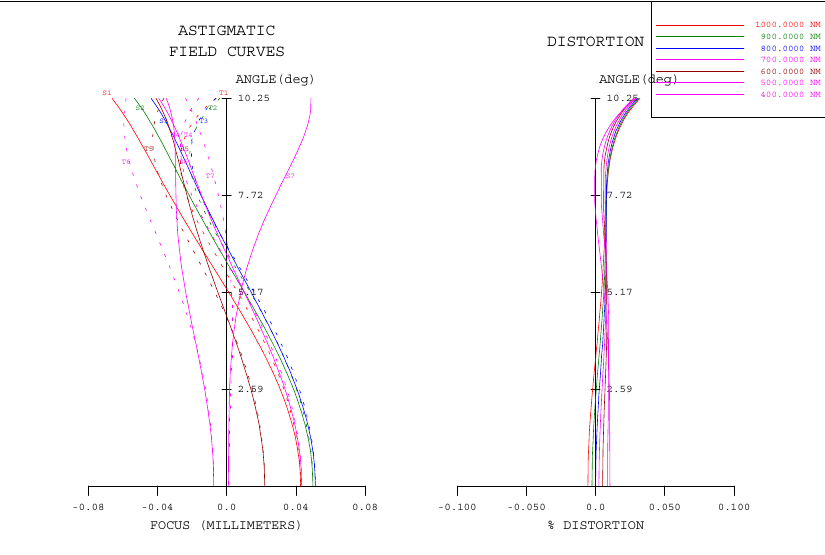
Figure 4. Field curves and distortion curves of optical system.